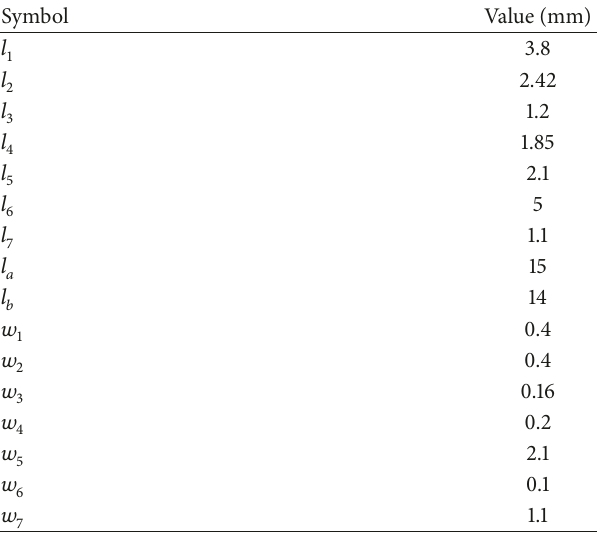
Table 1: Detailed parameters of the proposed